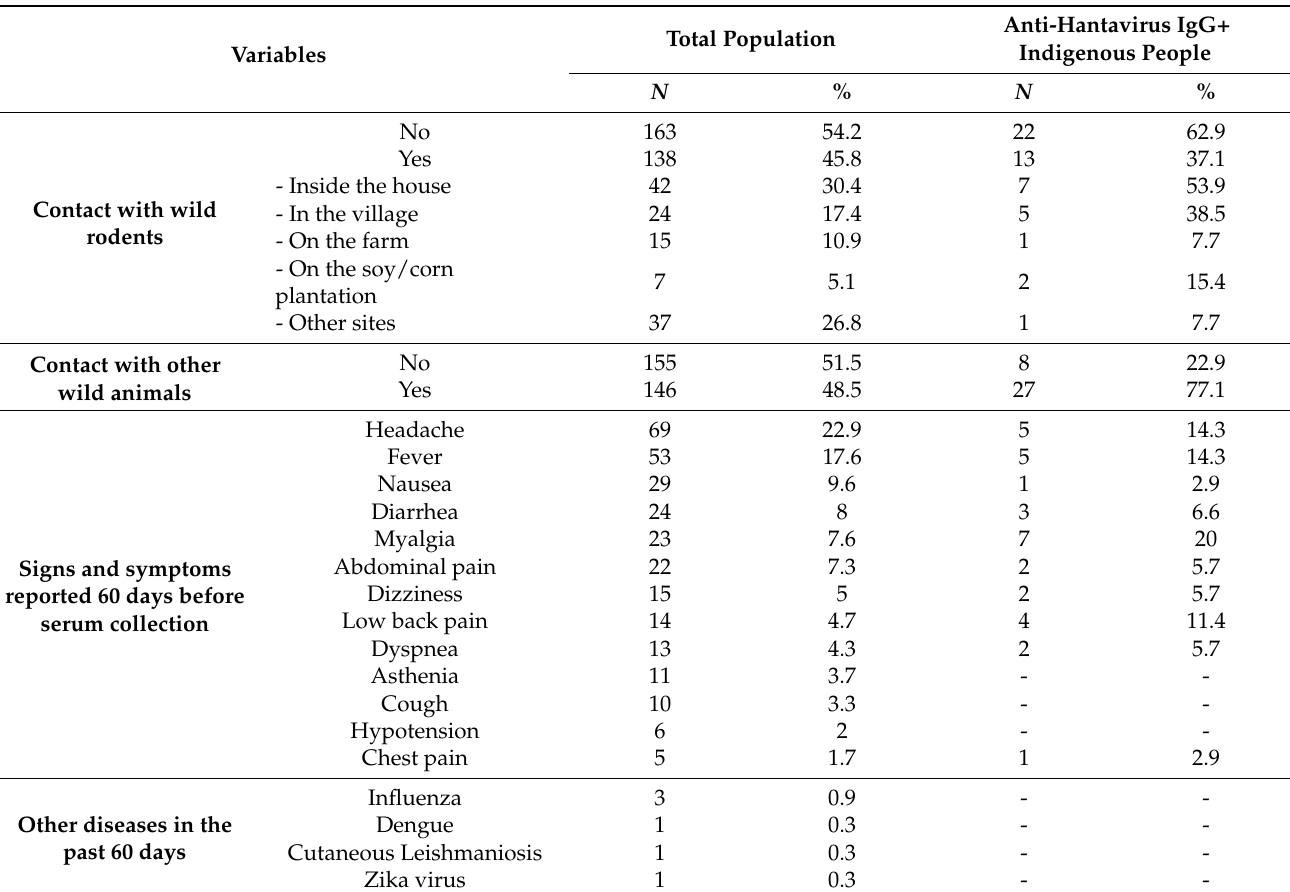
Table 2. Clinical and epidemiological history of the total Indigenous Haliti-Pares í population ( N = 301), Utiariti Indigenous land, Campo Novo do Parecis,